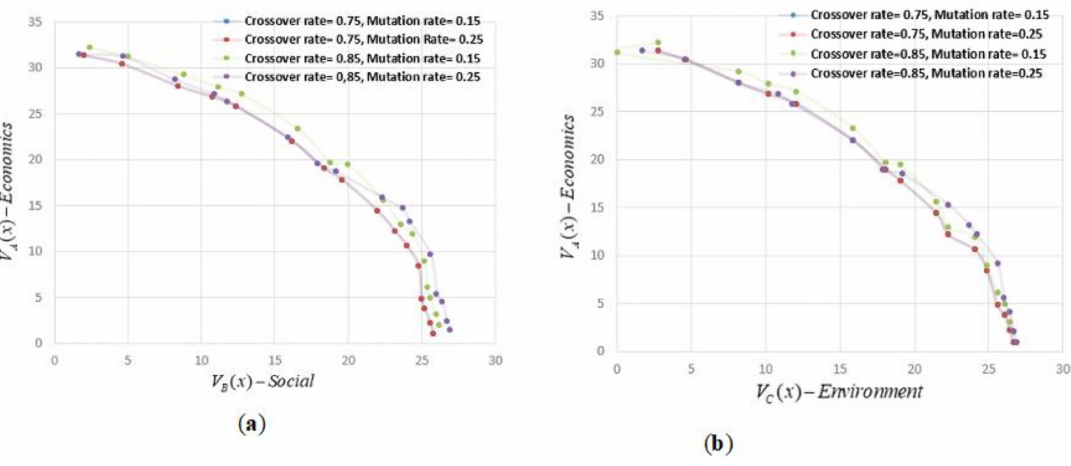
Figure 7. Pareto frontier considering di ff erent values of crossover and mutation rate. ( a ) ( ω A = 0.65; = 0.35; ω = 0.00); ( b ) ( ω ω B C